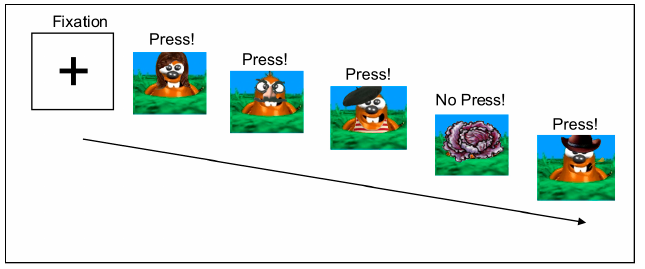
Figure 1. Go-NoGo Task Stimuli. Instructions were to press for all moles and not press for vegetables. Stimuli were presented for 250 ms with a jittered interstimulus index ISI averaging 1250 ms (range = 970–1530 ms).